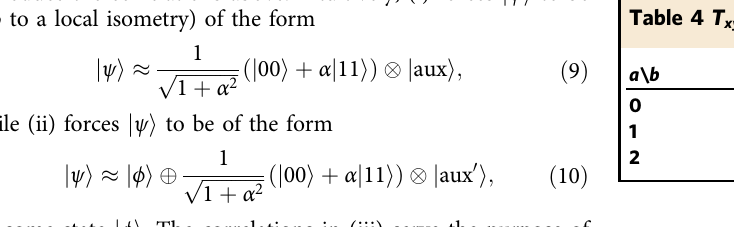
Table 4 T xy for x = 0, y =